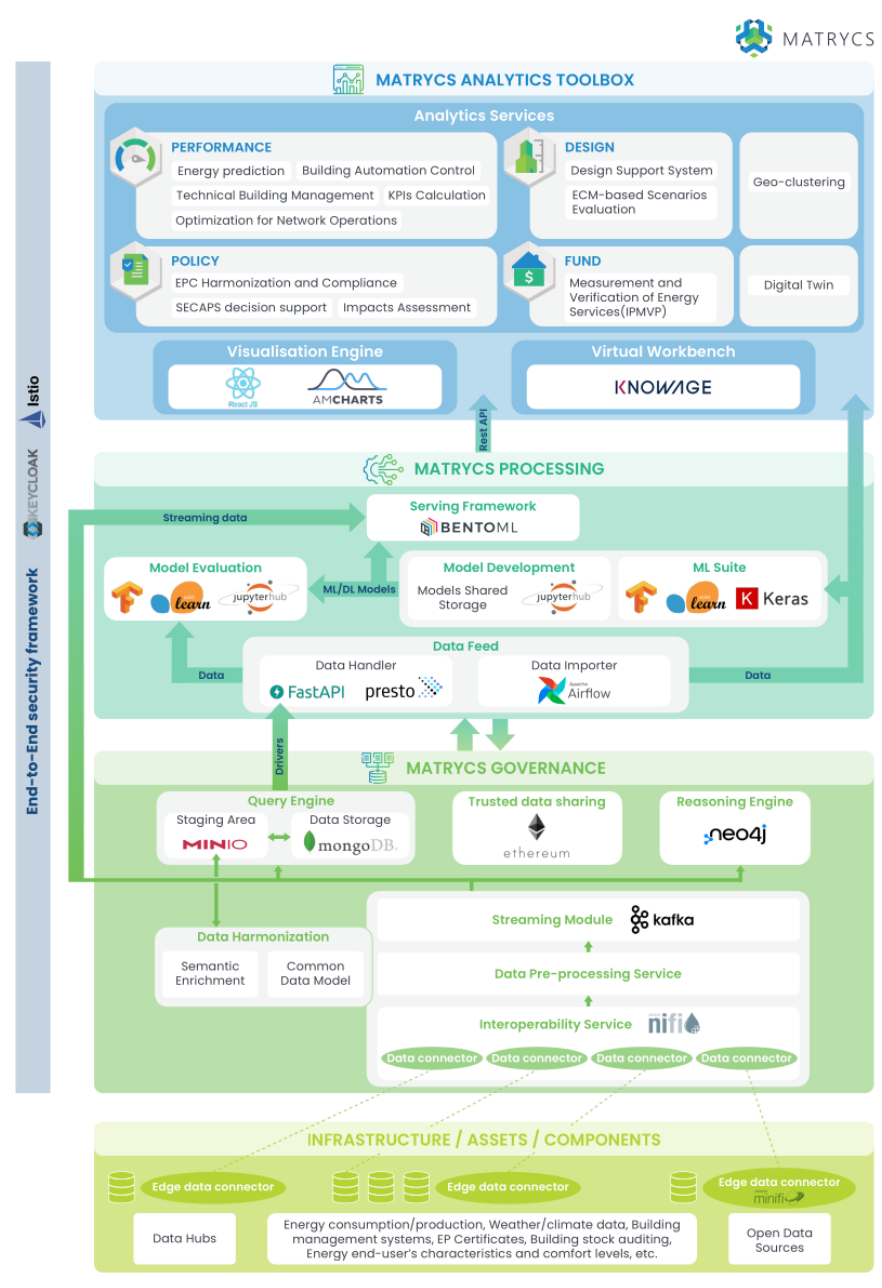
Figure 8. Practical instantiation of the MATRYCS architecture with open source